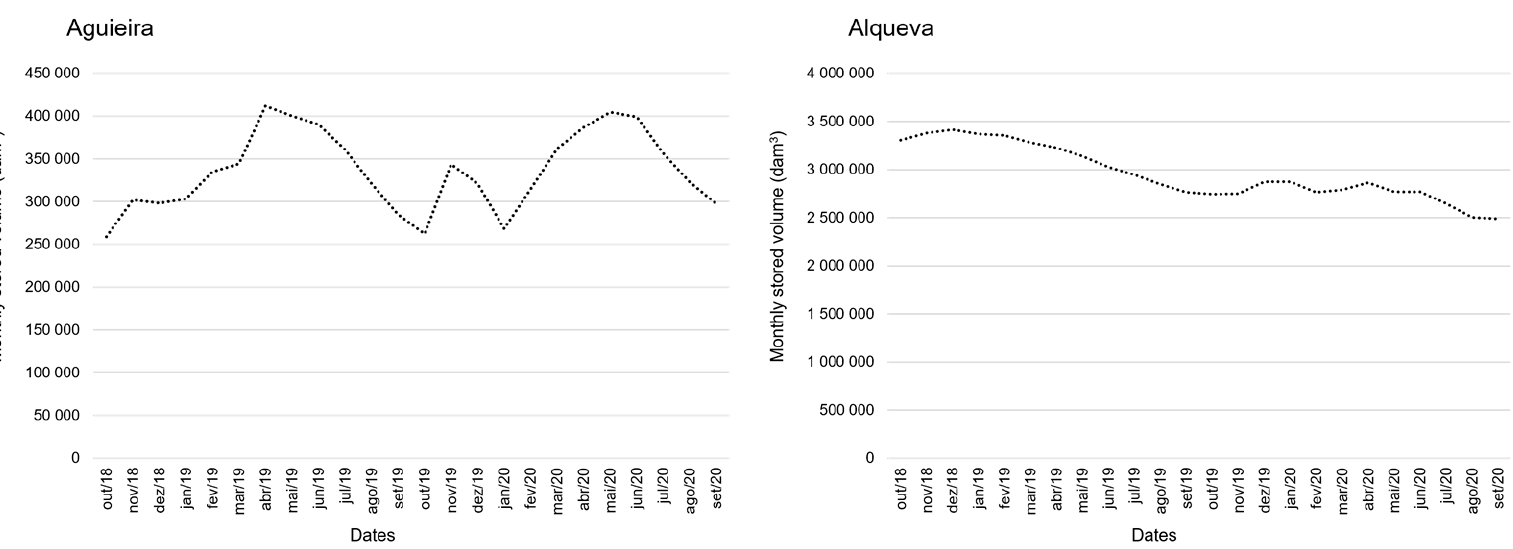
Figure A1. Monthly mean stored volume of water in Aguieira reservoir ( left ) and Alqueva Reservoir ( right ), for the last two water years (2018–2019 ad 2019–2020) [44].